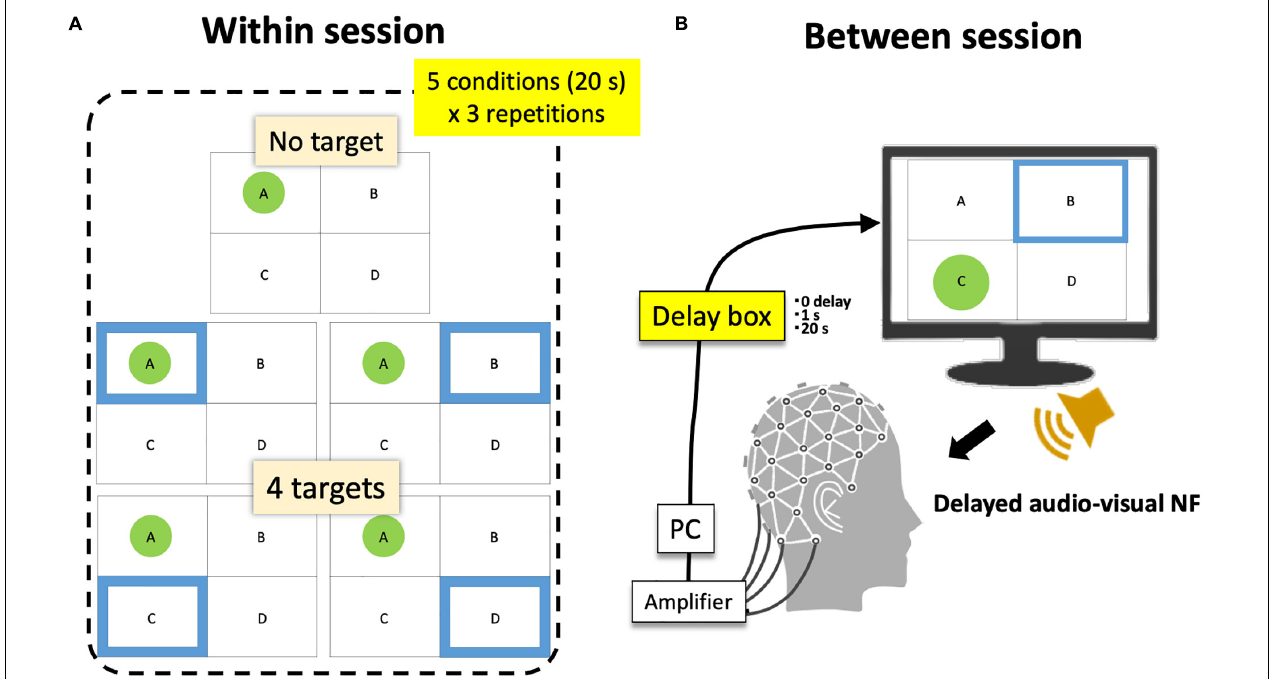
FIGURE 5 | Within- and between-session conditions. (A) A session consists of five within-session target conditions × 3 repetitions. (B) Participants completed 6 sessions (3 between-session delay conditions × 2 repetitions). The order of conditions was